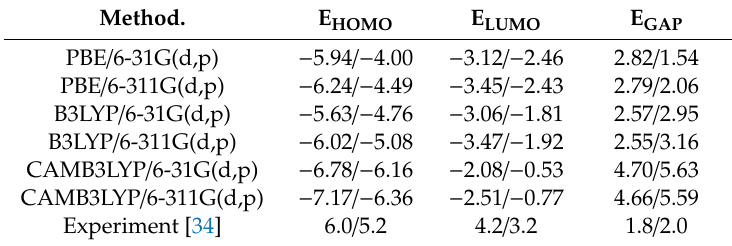
Table 1. Energy profiles highest occupied molecular orbital (HOMO), lowest unoccupied molecular orbital (LUMO) and their gap (E gap ) of the isolated P3HT oligomer, and PCBM. All the energies are in eV and PCBM / P3HT.